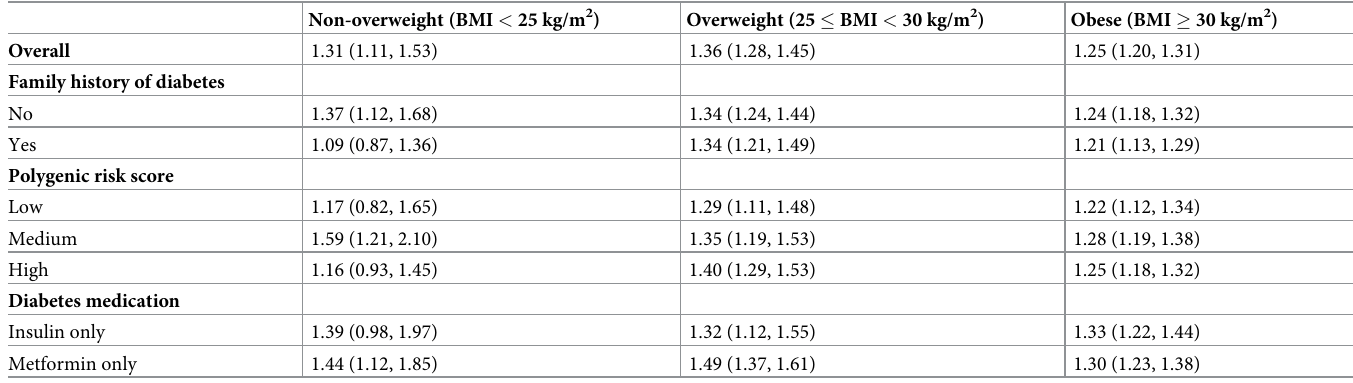
Table 2. Diabetes odds ratio per kg/m 2 increase in BMI within various subsets of individuals, according to inverse-variance-weighted Mendelian